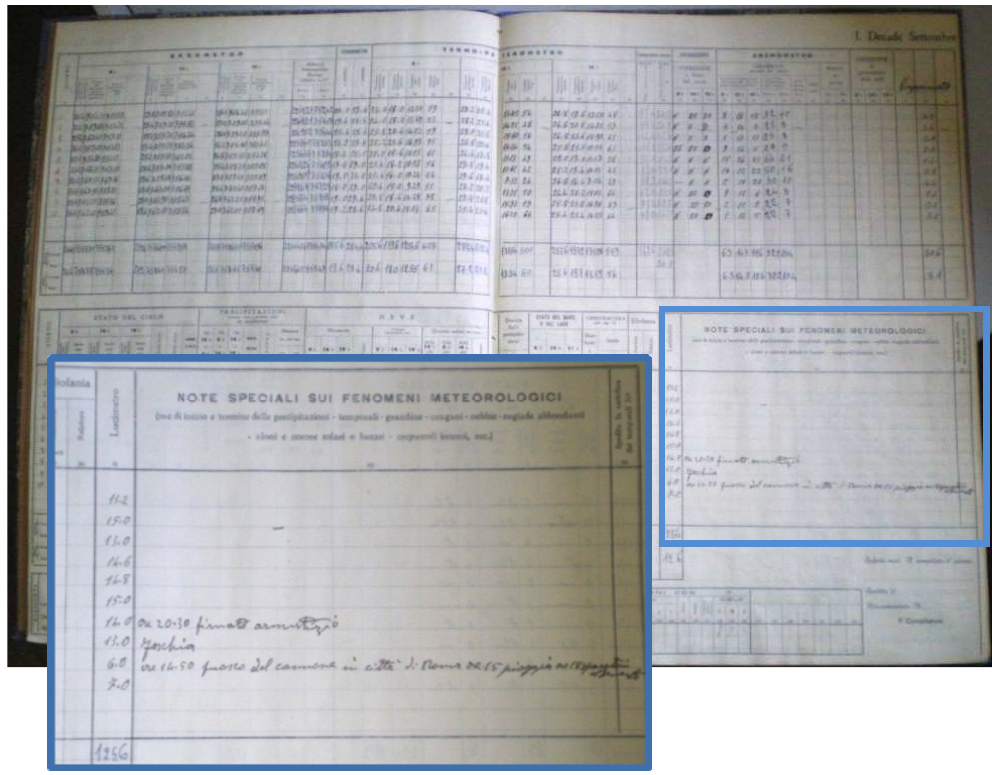
Figure 3. Collegio Romano Observatory: year 1943, September, the first ten days observation form. Weather notes and news about the Second World War are reported in “Special notes on the weather”: 7 September, 08:30p.m. – “The armistice” (Italy – Allied Countries) was signed; 8 September – Haze; 9 September, 02:50p.m. “Cannon shots in Rome”; 03:00p.m. “Rain”; 06:00p.m. “Shooting in the Italian